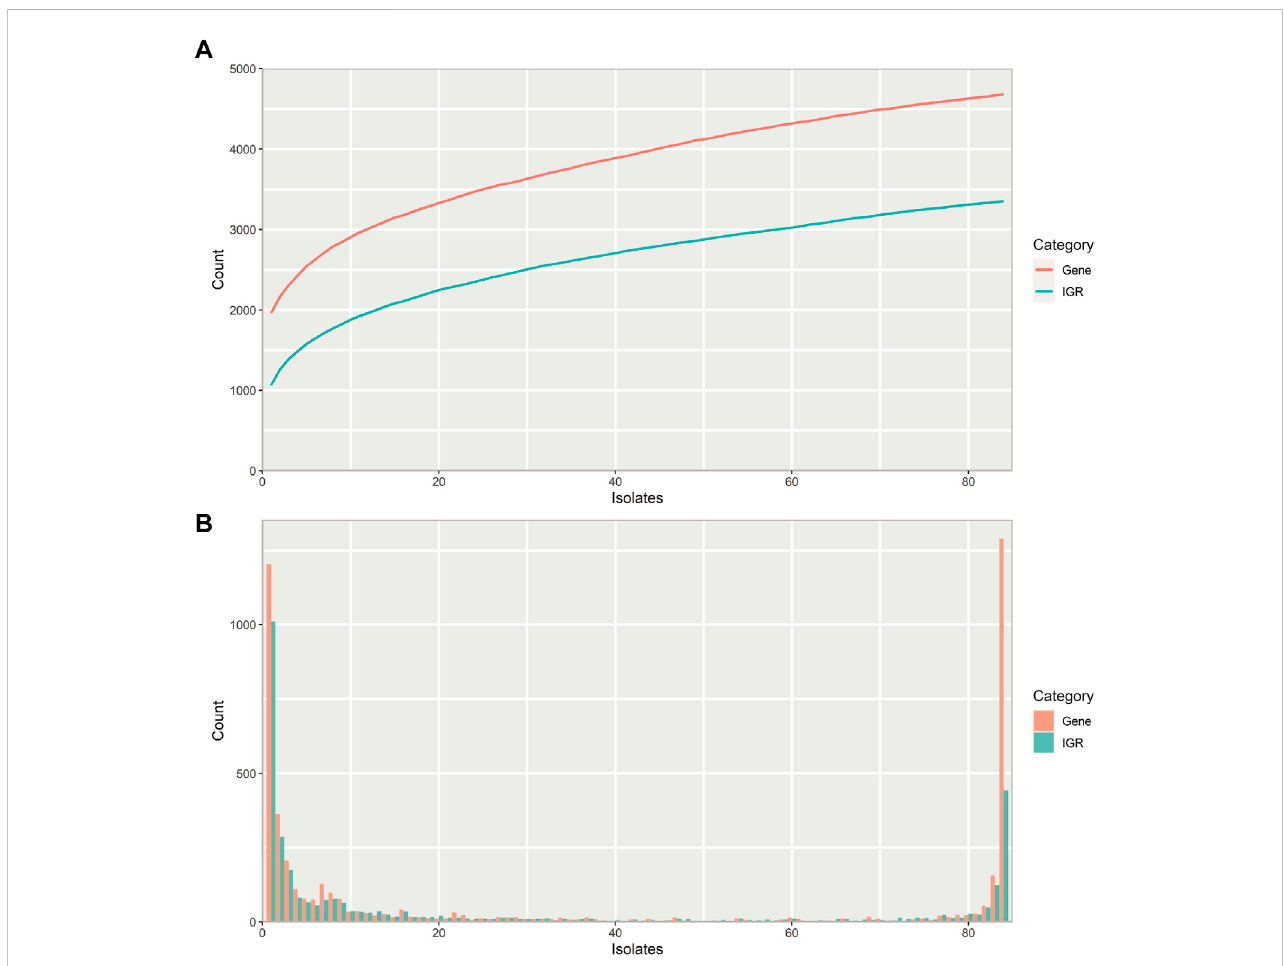
FIGURE 2 Properties of the pneumococcal pangenome and its intergenic regions (IGRs) (A) Number of unique intergenic regions (green) and genes (orange) as a function of the number of isolates included in the pangenome. (B) Distribution of unique IGRs (green) and genes (orange) across the streptococcal pangenome, illustratedwith a frequency histogram (number of IGRs/genespresent in the given number of isolates). Most IGRs and genes are part of the core genome or con fi ned to a small fraction of the